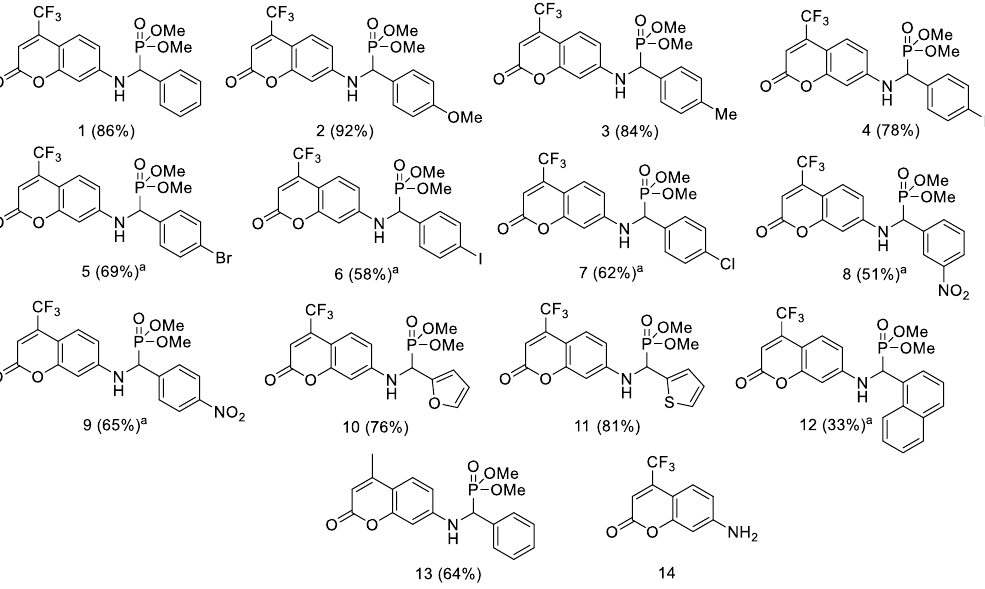
Figure 3. The synthesis of various coumarin α -aminophoshonates 1-13 under optimized conditions. Reaction conditions: aldehyde (1 mmol), 7-amino-4-(trifluoromethyl)coumarin (1 mmol), dimethyl phosphite (1 mmol), and Novozym 435 (80 mg) in neat for 18 h at 30 ◦ C, 200 rpm. a 2-Me-THF (2 mL). Yields in brackets provided for isolated products 1 – 13